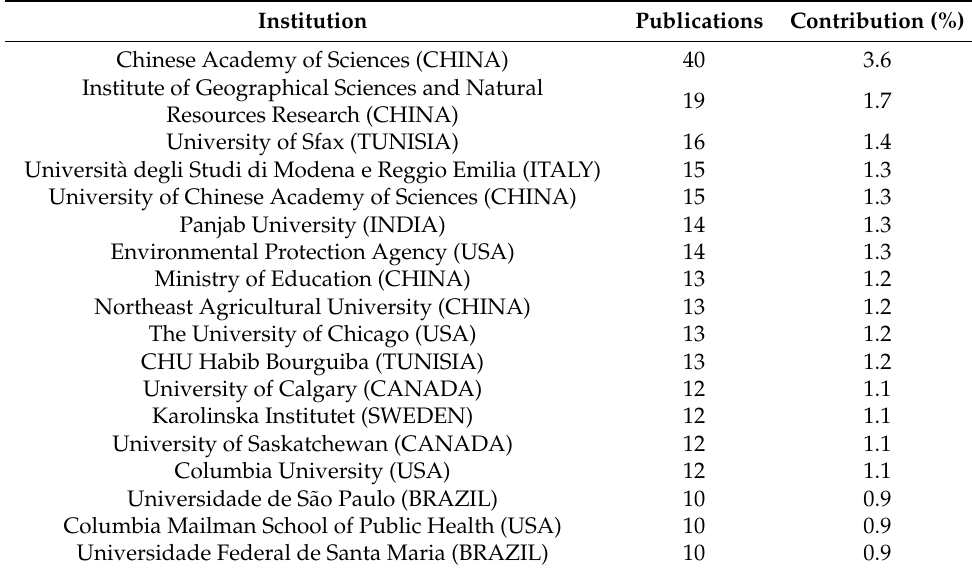
Table 3. The top 18 most productive institutions (at least 10